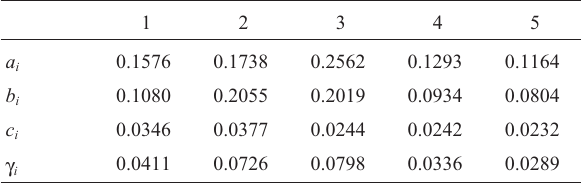
Table 3 - Standard deviations for the 1000